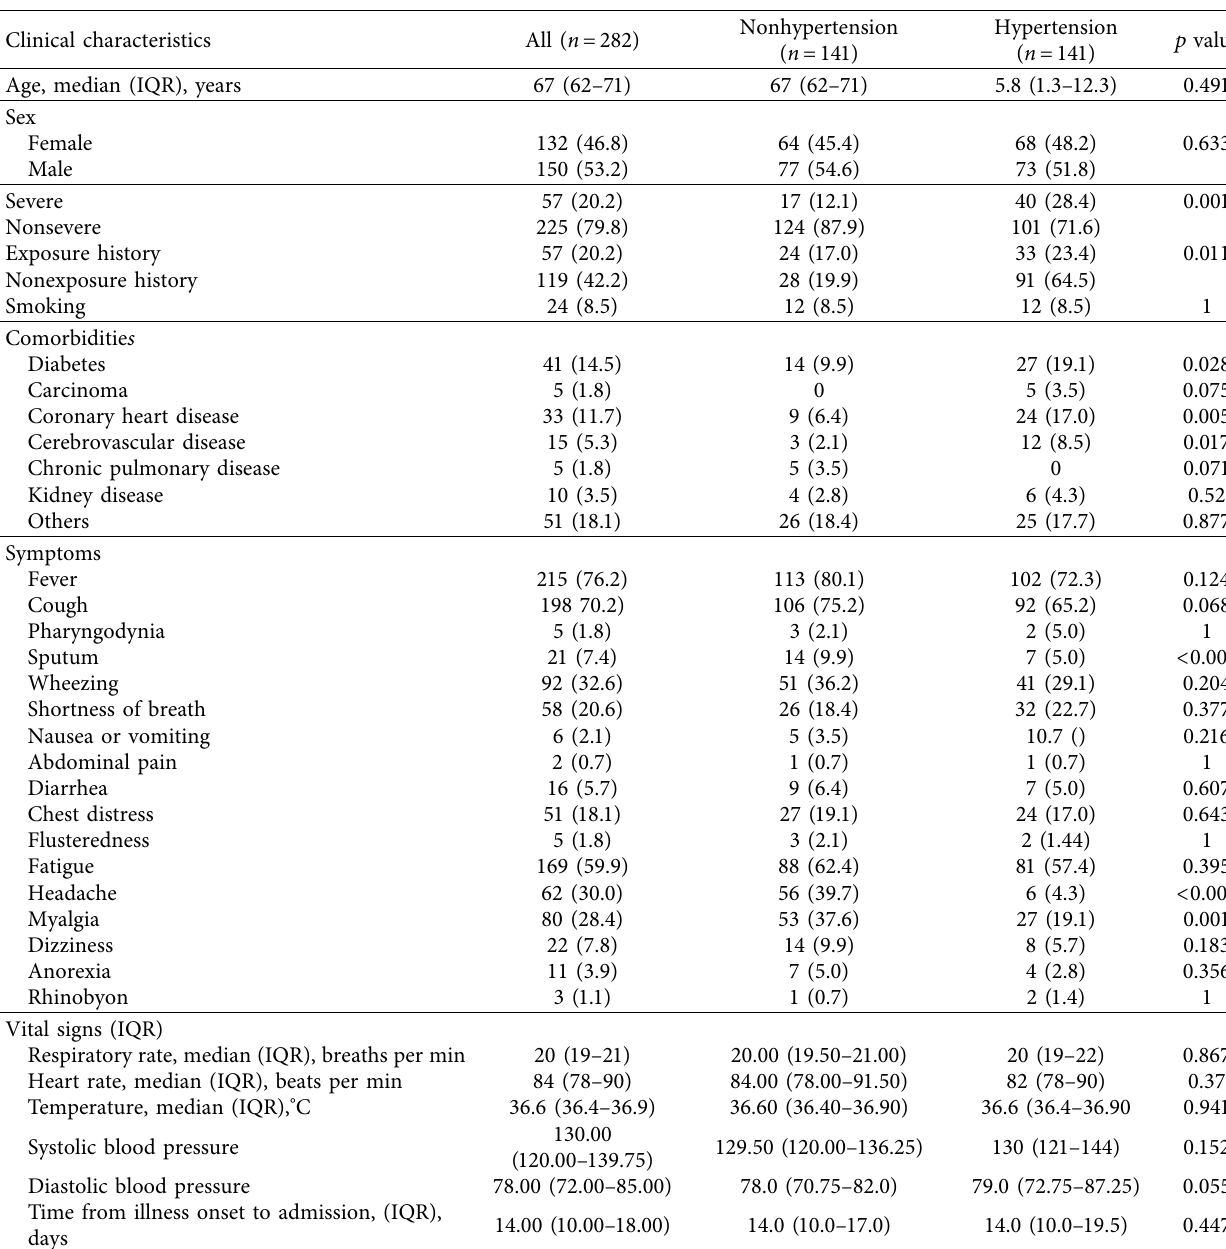
Table 1: Demographic and clinical characteristics of 282 patients with